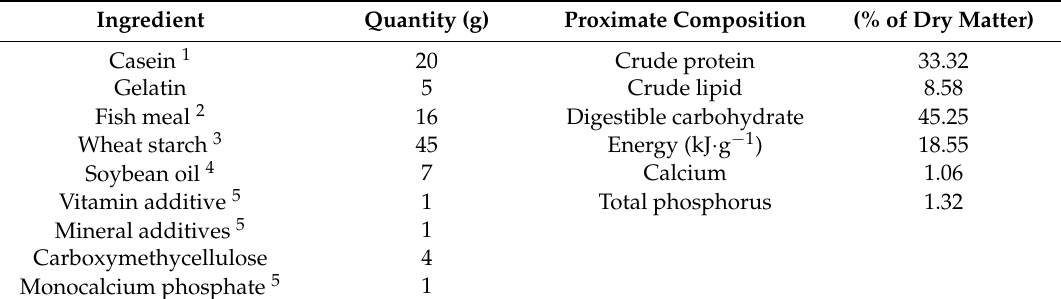
Table 5. Formulation and proximate composition of the HSD